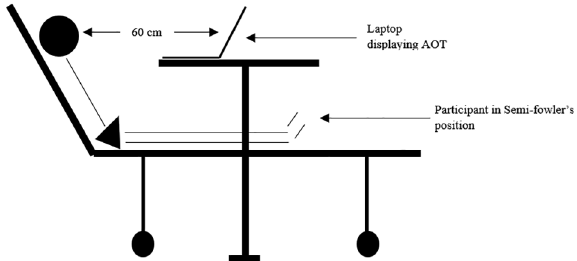
Figure 1. Position of the participant during action observation